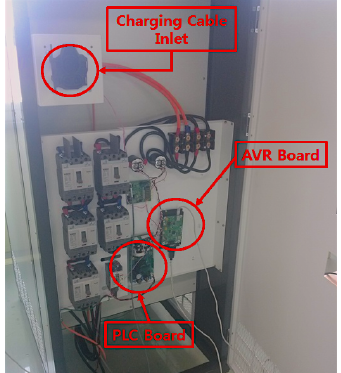
Figure 8. Hardware adaptor of the test system.